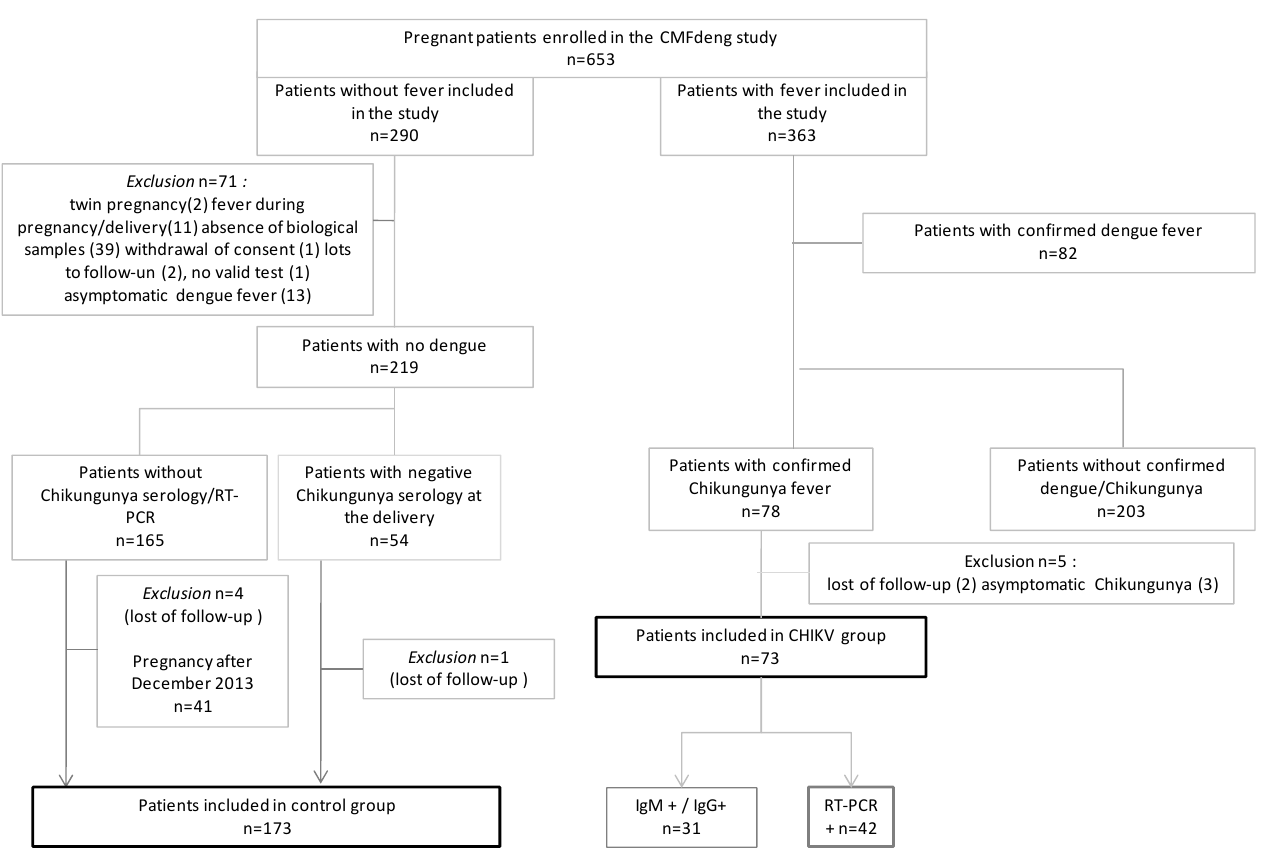
Figure 1. Study flow chart, pregCHIKV study 2022 [16].